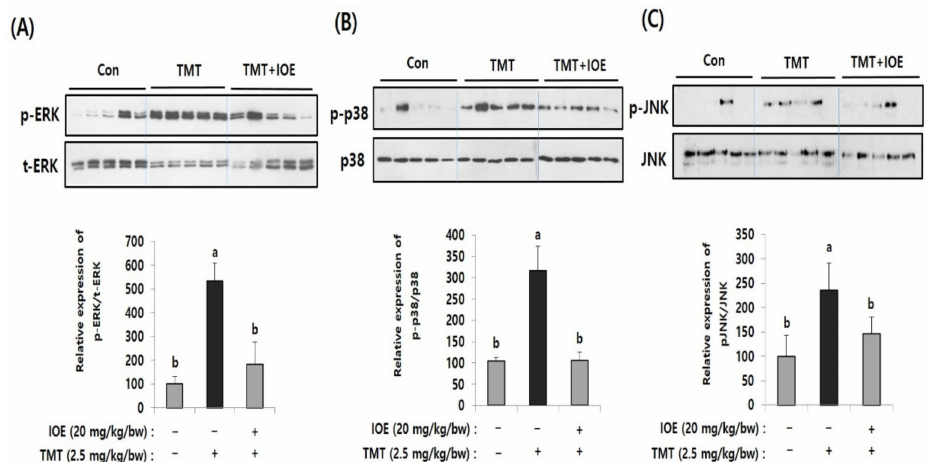
Figure 5. TMT-induced abnormal phosphorylation of mitogen-activated protein kinases (MAPKs) in the brains of each mouse group was restored by oral administration of IOE. Phosphorylation of extracellular signal-regulated kinase (ERK) ( A ), p-38 MAPK ( B ), and c-jun N -terminal kinase (JNK) ( C ) in mouse brains ( n = 5) were measured by Western blotting. The density of each band was estimated by ImageJ program and the relative expression rates of ERK (p-ERK/t-ERK), p38 (p-p38/p38), and JNK (p-JNK/JNK) were calculated and tabulated. Data shown are means ± SD. Con: control (non-treated)). a: significant differences ( p < 0.05) when compared with